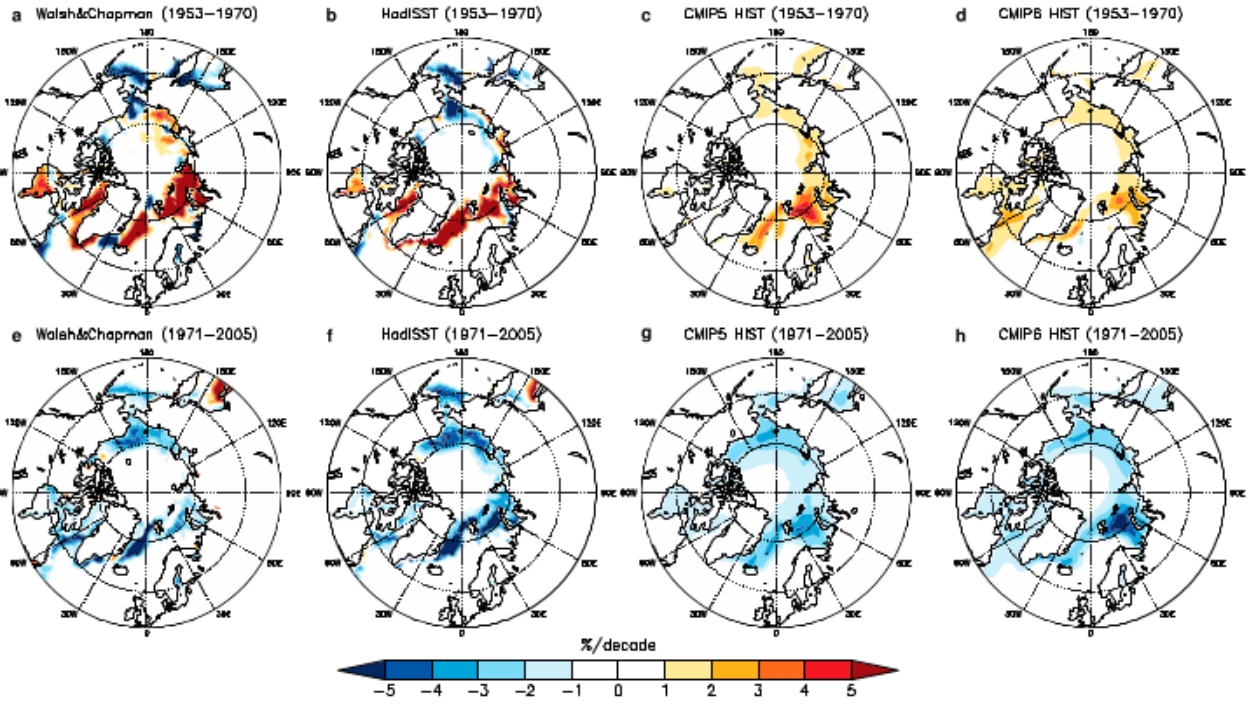
Figure 4. ( a – d ) Linear trends of annual mean sea ice concentrations (shading in percent/decade) from ( a ) Walsh and Chapman and ( b ) HadISST data and the MMMs of ( c ) CMIP5 and ( d ) CMIP6 historical simulations during 1953–1970. ( e – h ) Same as ( a – d ) but for the period of